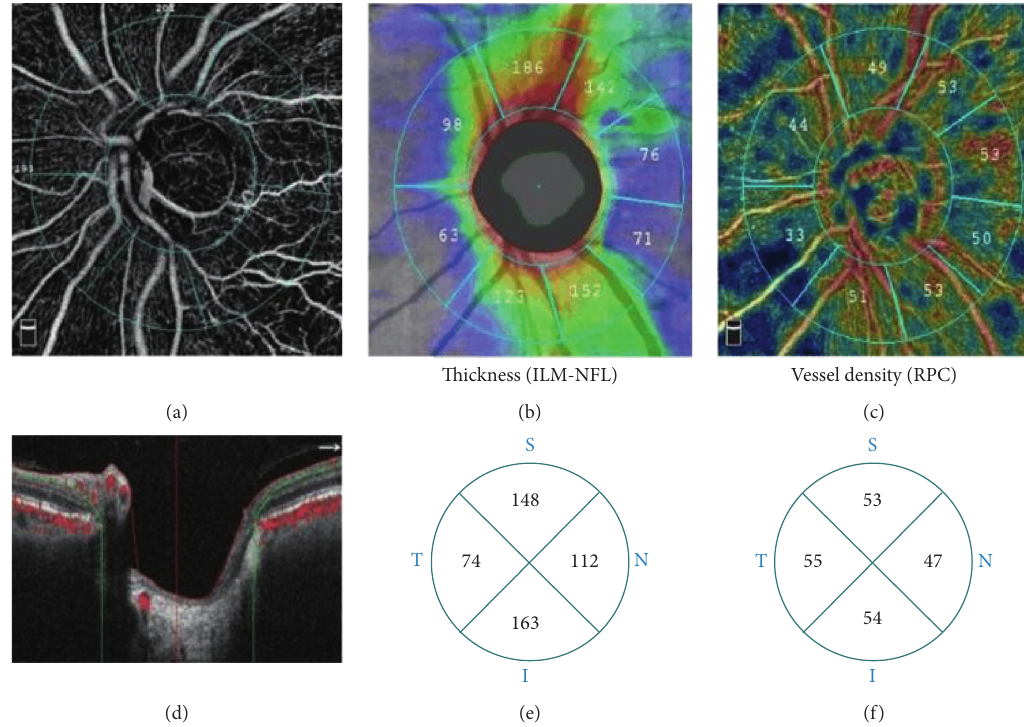
Figure 1: OCTA measures the parameters of the optic disc in the range of 4.5mm × 4.5mm. (a) Inside the optic disc: area surrounded by the inner blue circle; the peripapillary region: area between two blue rings. (b) RNFL thickness around the optic disc. (c) Peripapillary vessel density. (d) Peripapillary vessel measurement RPC layer range (ILM to NFL layer). (e) Peripapillary RNFL thickness four-quadrant zone. (f) Peripapillary vessel density four-quadrant zone.